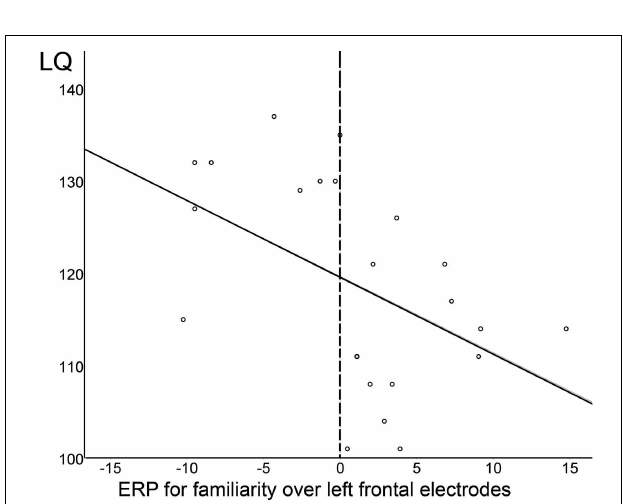
FIGURE 7 |The more negative the familiarity effect at 7months (i.e. the more negative the difference wave between familiarized target and unfamiliar control words in the 350–450ms time window over left frontal electrodes), the higher the quotient for word production at 3years. The dotted line indicates the split between Negative and Positive